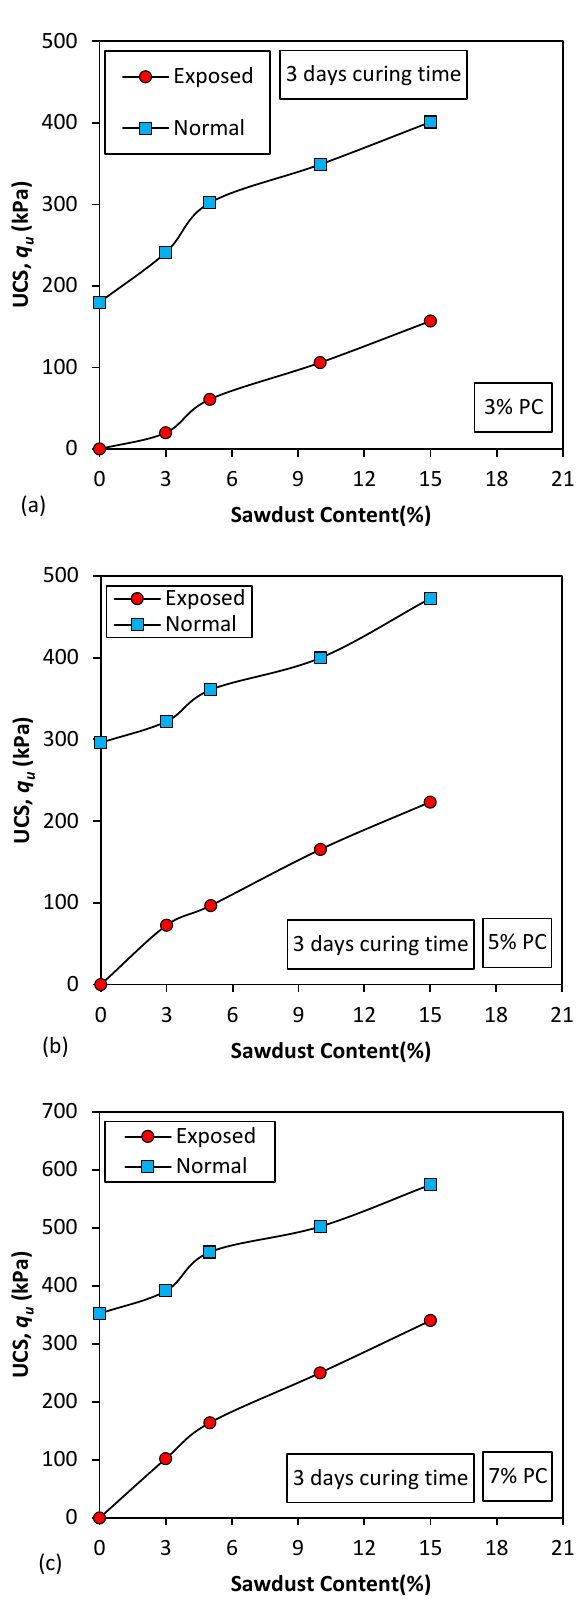
Figure 6. Effect of sawdust addition on Unconfined Compressive Strength (UCS) peak values (3 days curing) ( a ) 3% PC; ( b ) 5% PC; ( c ) 7% PC.